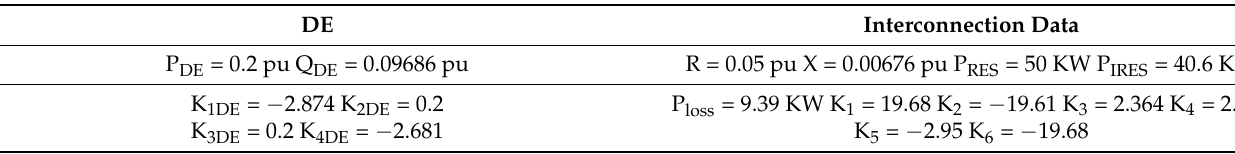
Table A3. Diesel engine and AC tie line parameters